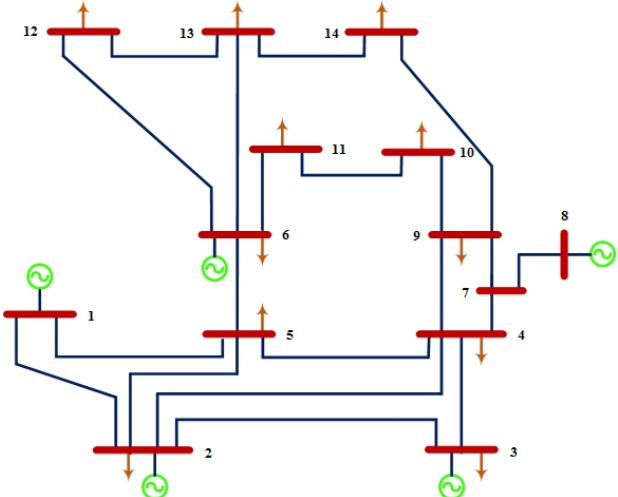
Figure 2. Standard IEEE 14-bus.